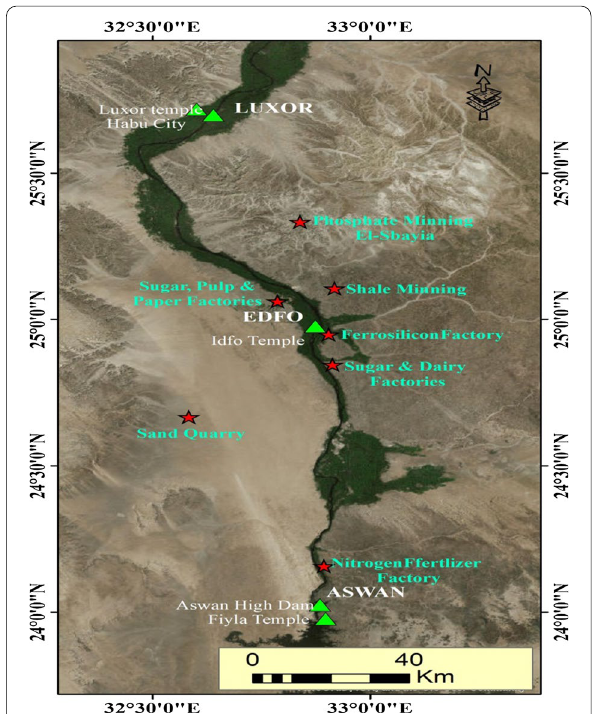
Fig. 1 Location of the studied localities in satellite